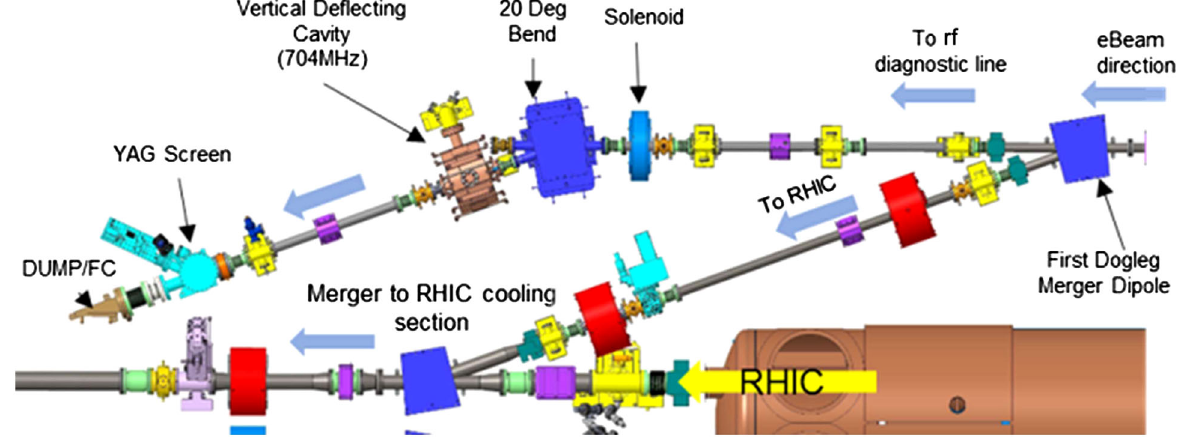
FIG. 5. The rf diagnostic line layout.